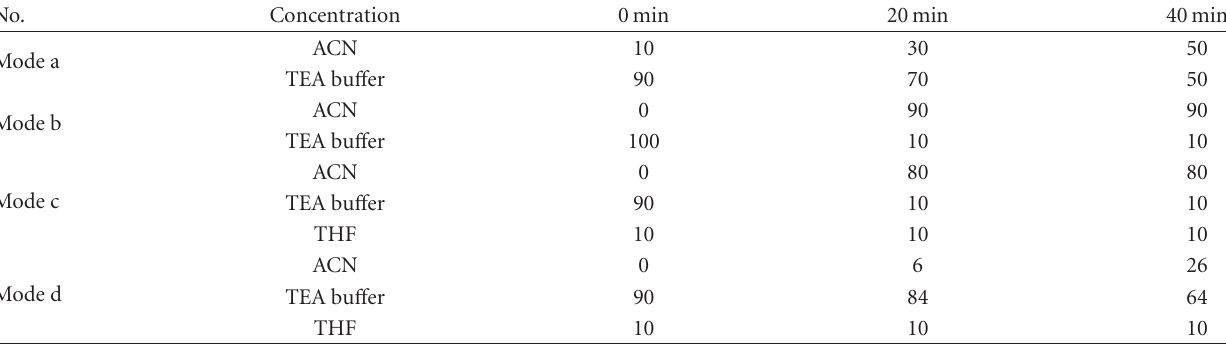
Table 1: Di ff erent gradient elution programs for the HPLC analysis of A, MA, HA, and their correlative semi-hydrolyzed products.